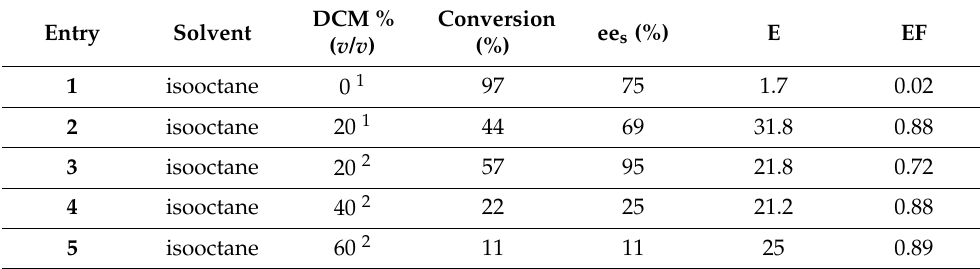
Table 2. Effect of DCM percentage on the kinetic resolution of rac -ibuprofen.